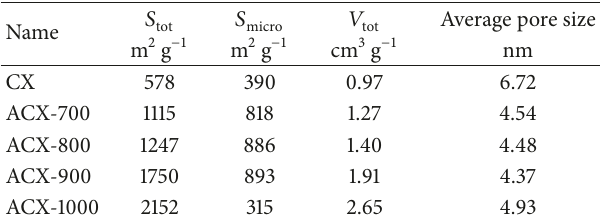
Table 1: Characteristic properties of carbon xerogels and activated carbon